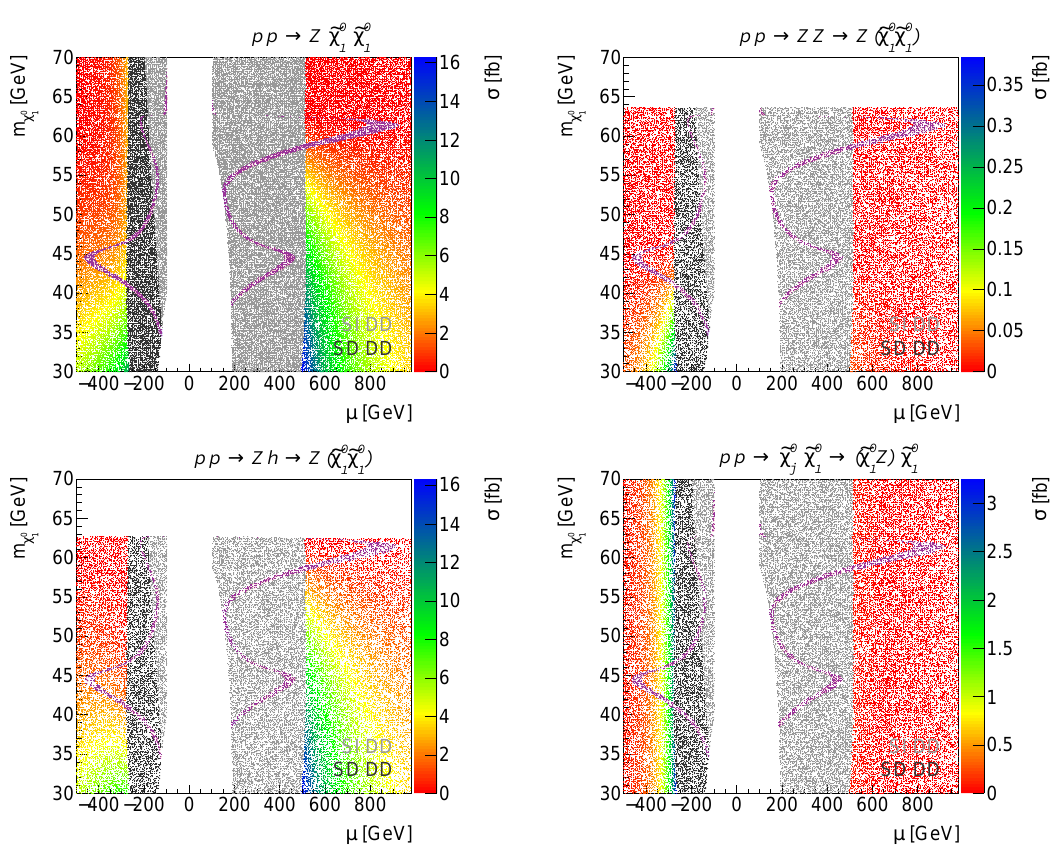
Figure 9: Mono- Z cross sections with DD limits, but without requiring the observed relic density (upper left). Again, we show the three LHC topologies separately (upper right to lower right). Points excluded by spin-independent DD limits are light gray, points excluded by spin-dependent direct detection in dark gray. Points that match the observed relic density under standard assumptions are shown in